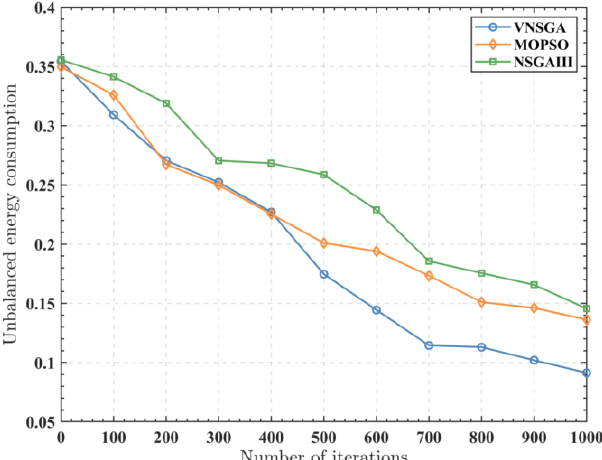
Figure 24. Unbalanced energy consumption for three algorithms with different iterations with respect to area B.